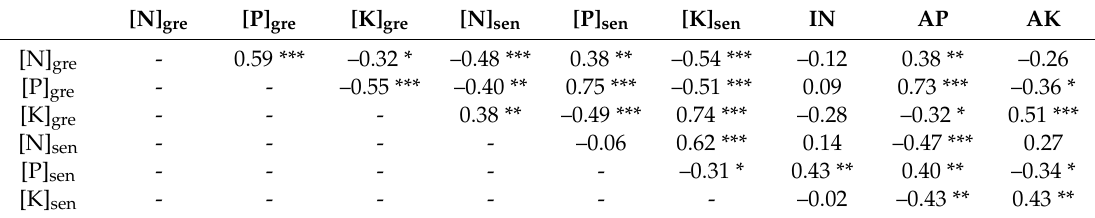
Table 2. Correlation between nutrient concentrations in mature and senescent leaves and soil-available nutrients.